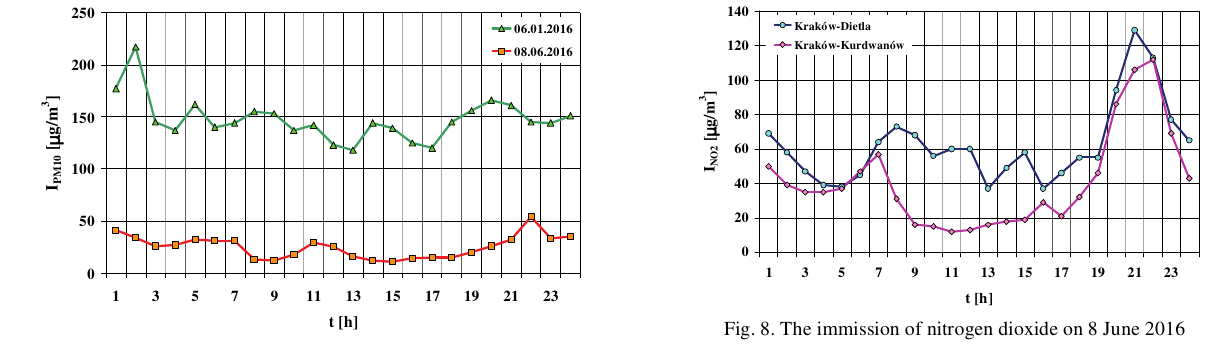
Fig. 5. The immission of particulate matter PM10 values obtained from Kraków–Kurdwanów station on 6 January 2016 and 8 June 2016 The similar comparison was made for the immission of nitrogen dioxide, a dominant pollutant in summer months.